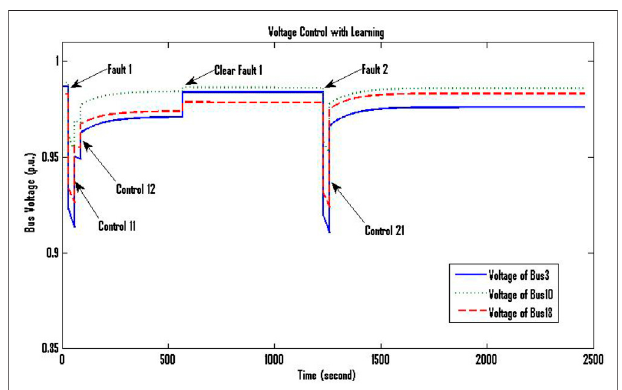
FIGURE 8 | System performance after learning